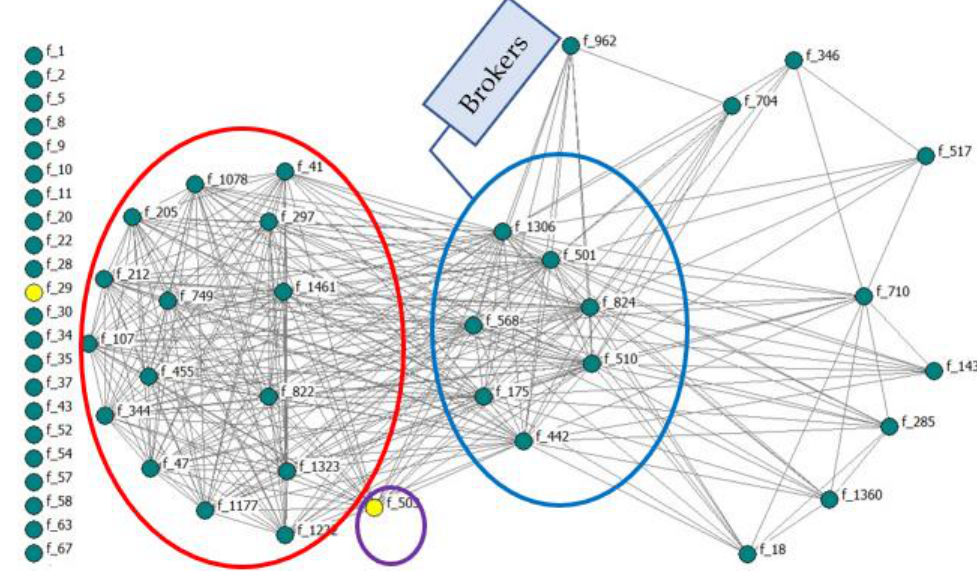
Figure 1 . One - mode network visualization of farmers with an adoption higher than 57%. Farmer code (f_ni). Nodes’ colour by gender: Women, Men.